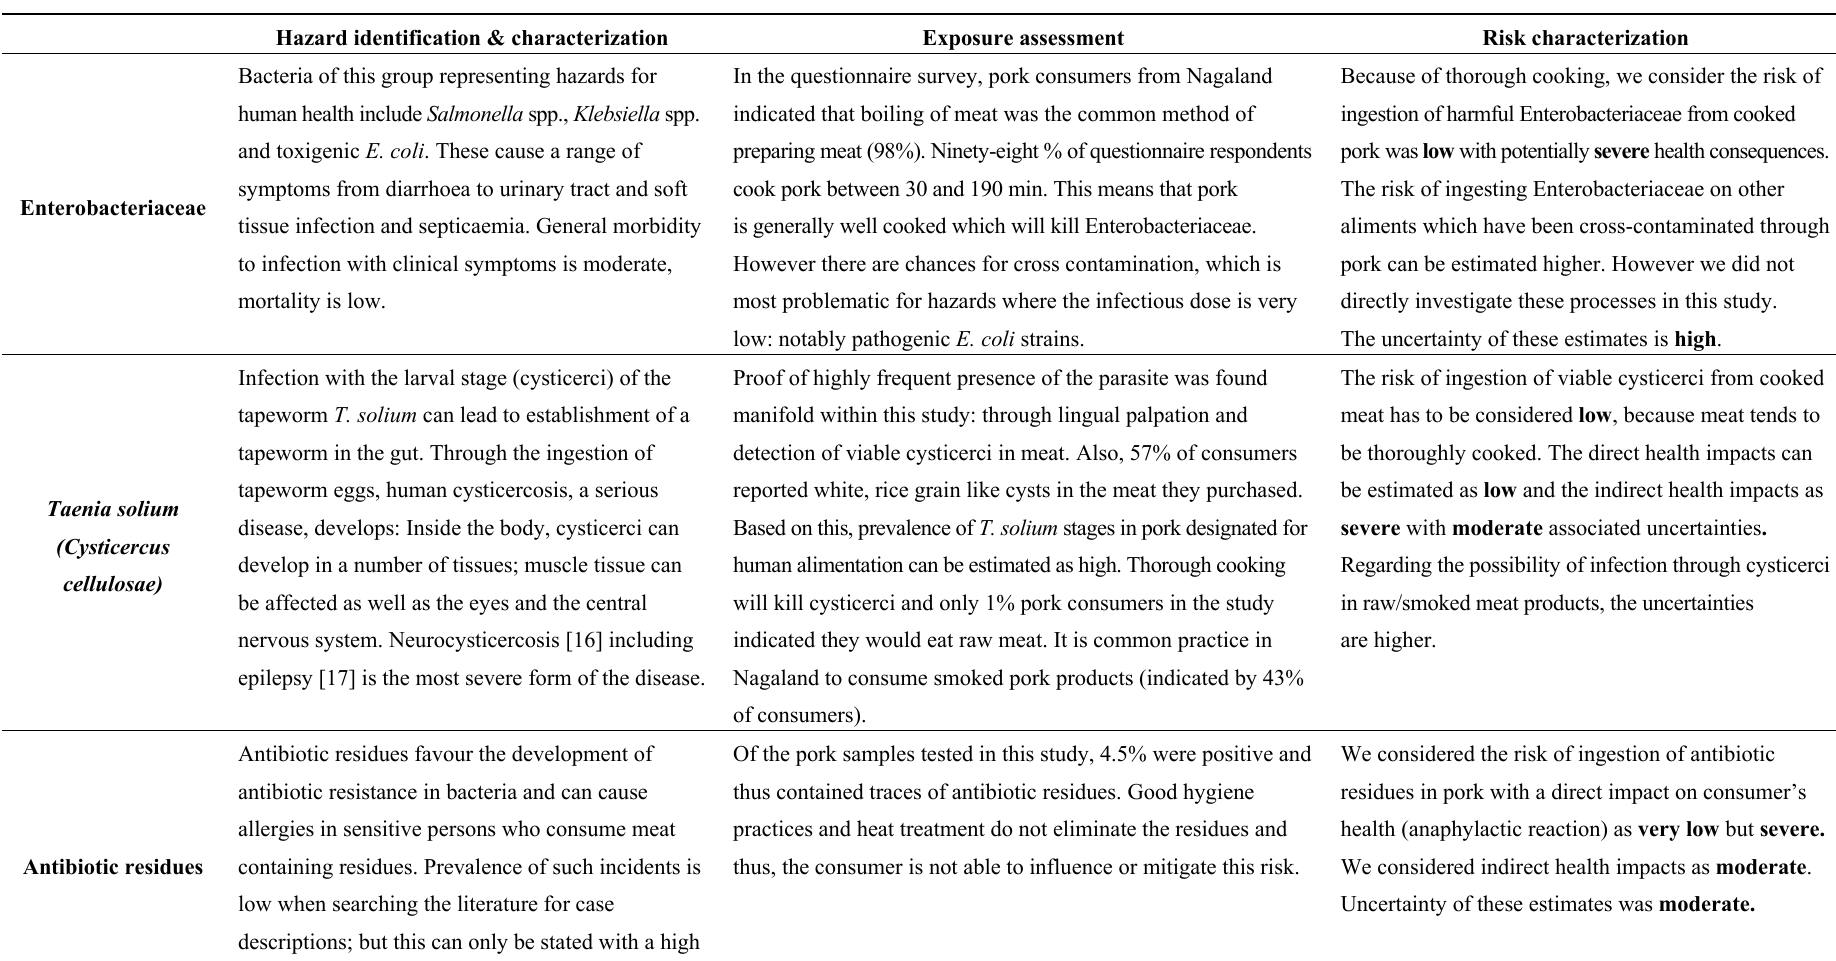
Table 2. Three selected hazards found in pork in Kohima, Nagaland, displayed in a qualitative risk assessment